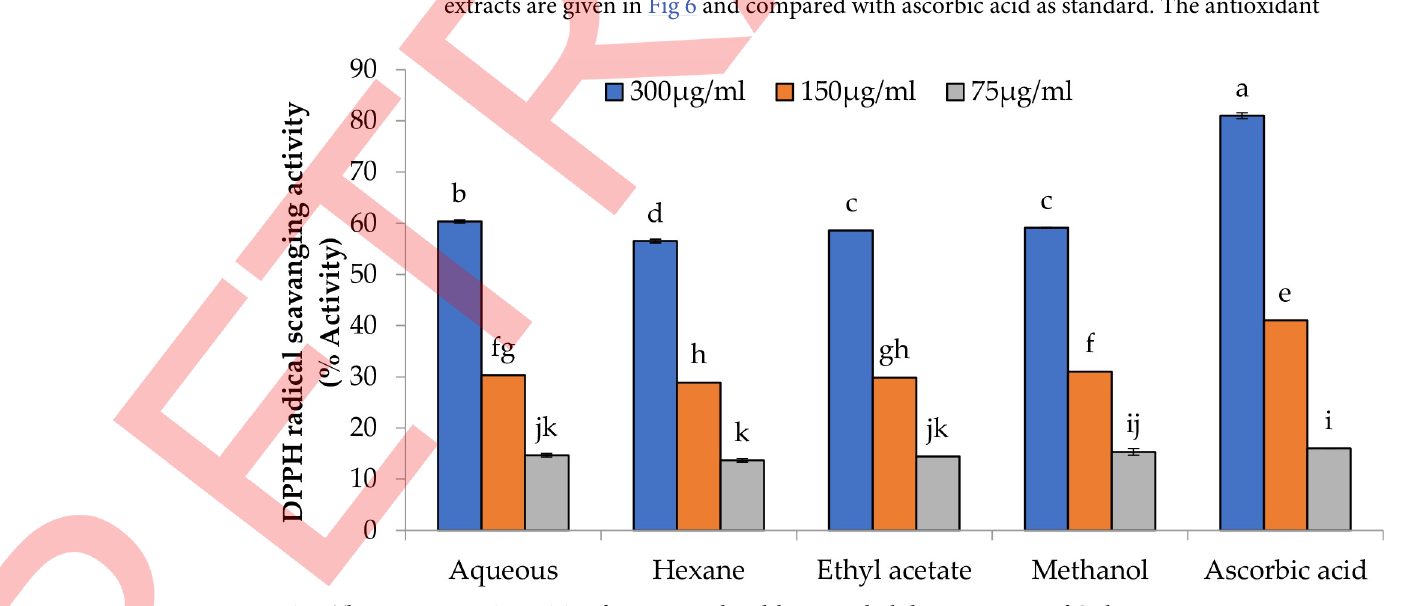
PLOS ONE | https://doi.org/10.1371/journal.pone.0255502 October 29,